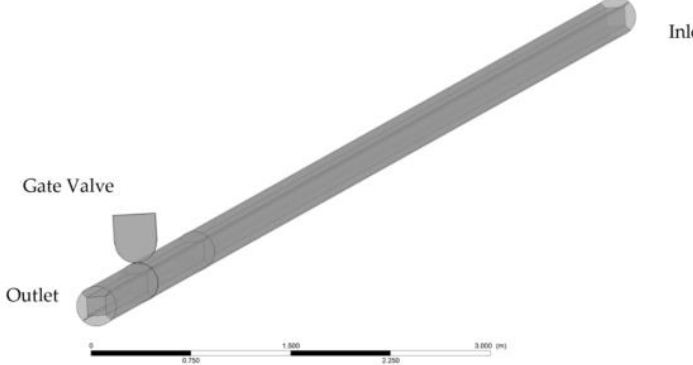
Figure 2. The boundary conditions and geometry used for the simulation.